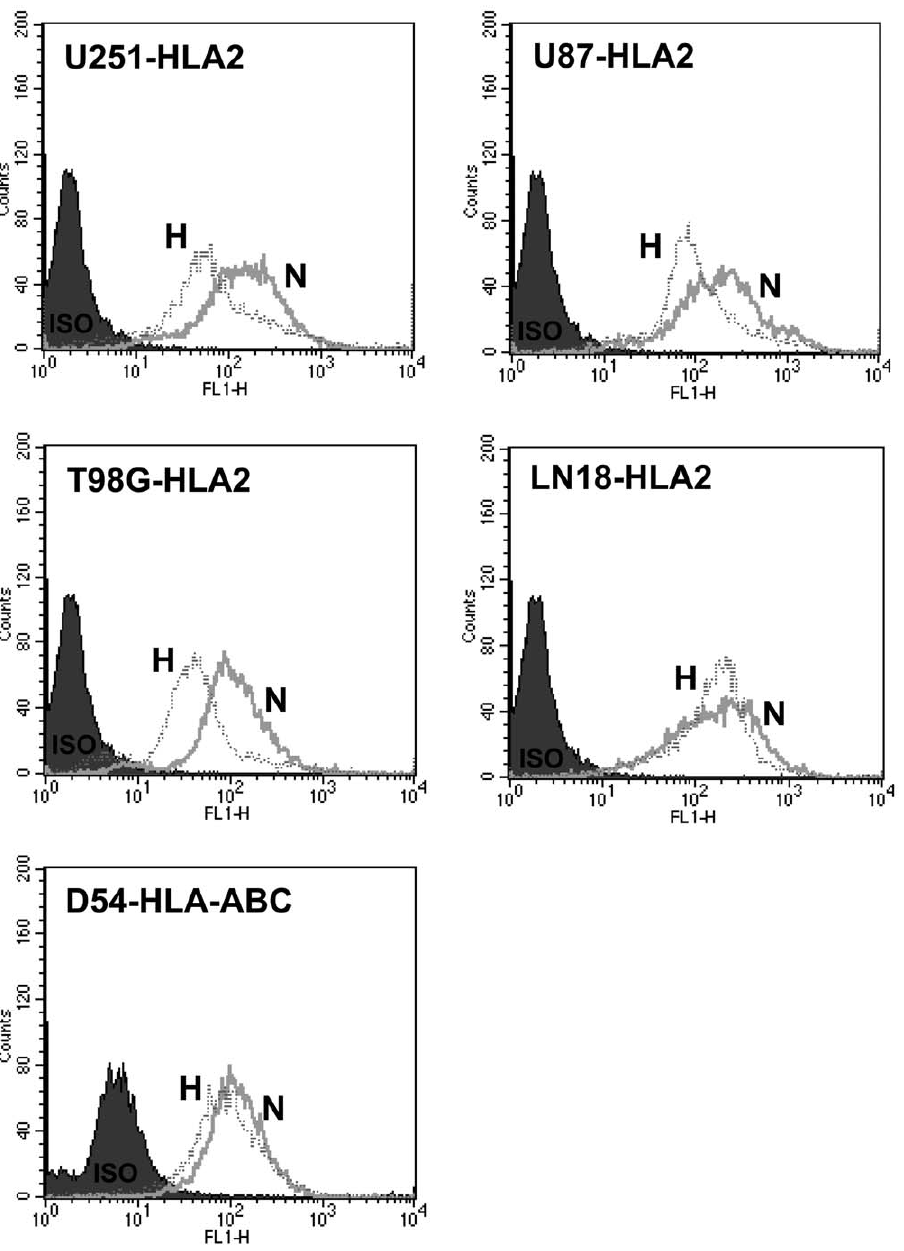
Figure 7. Comparison of HLA-Class I profiles of human glioma cells grown under hypoxic or normoxic conditions. The U251, U87, T98G, LN18 or D54 glioma cells were either grown under normoxic or hypoxic conditions for 1 week. The cells were stained for either cell-surface HLA-A2 (U251, U87, T98G and LN18) or HLA-ABC framework (D54) specific antibodies. Ten thousand cells were analyzed by flow cytometry. The profile or the hypoxic cells (labeled H, indicated by heavy line) is compared to the shaded normoxic cells (labeled N, indicated by thin line). The isotypic controls of the normoxic and hypoxic cells are superimposable and are shown as a single black shaded profile.